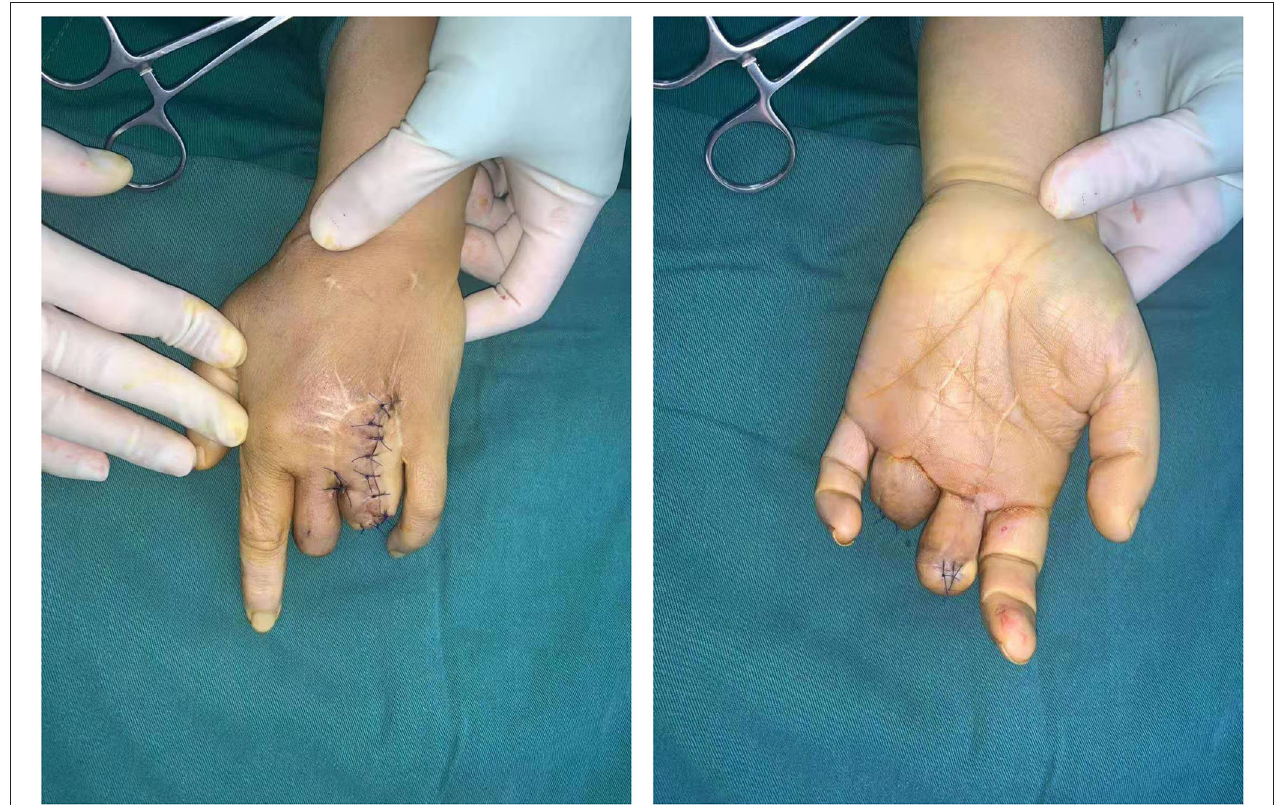
FIGURE 4 | Appearance after flap thinning